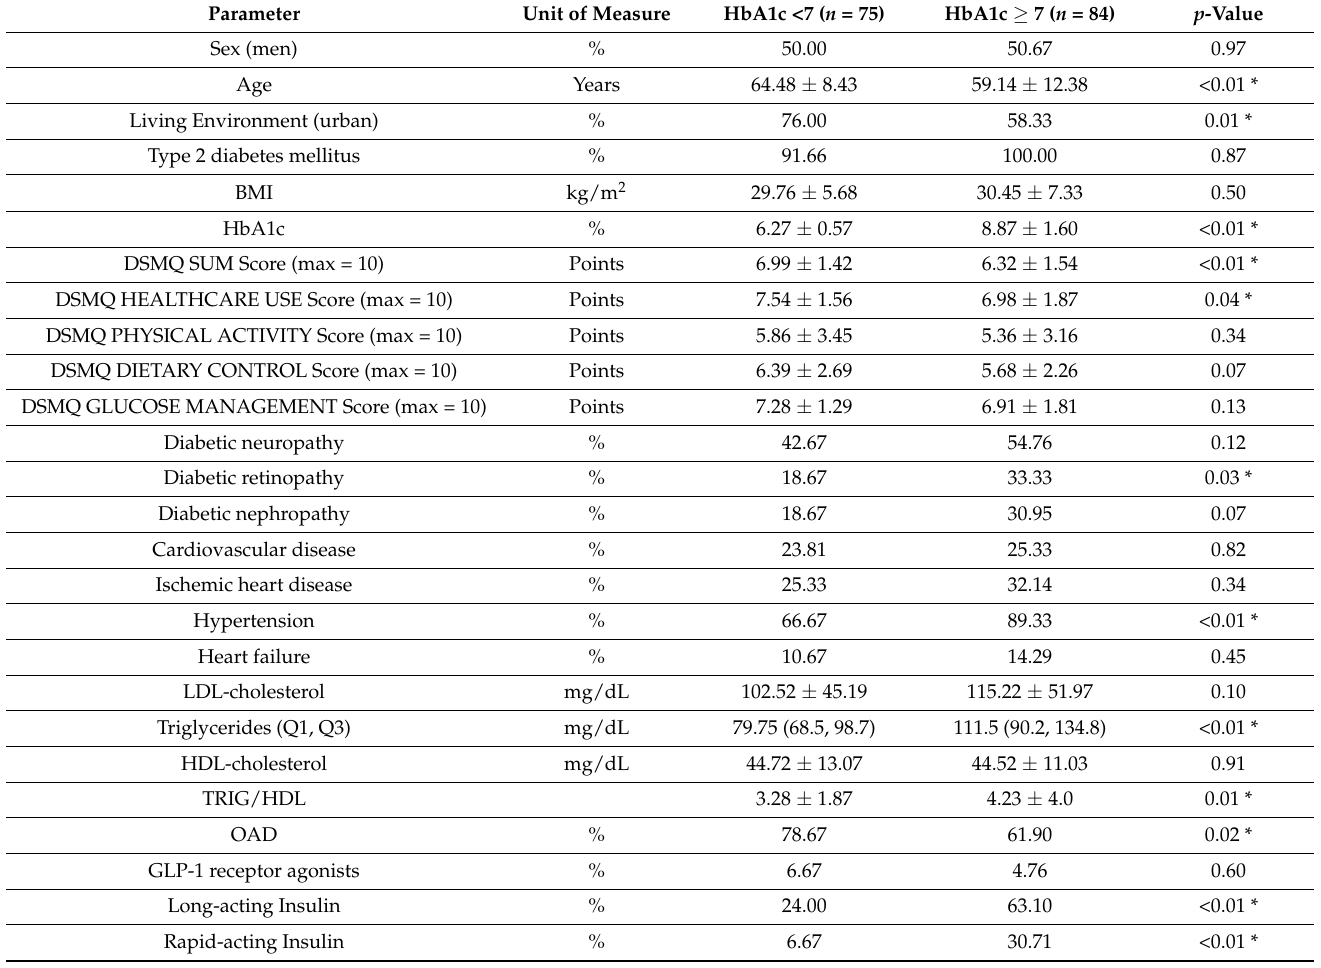
Table 1. Characteristics of the included patients.